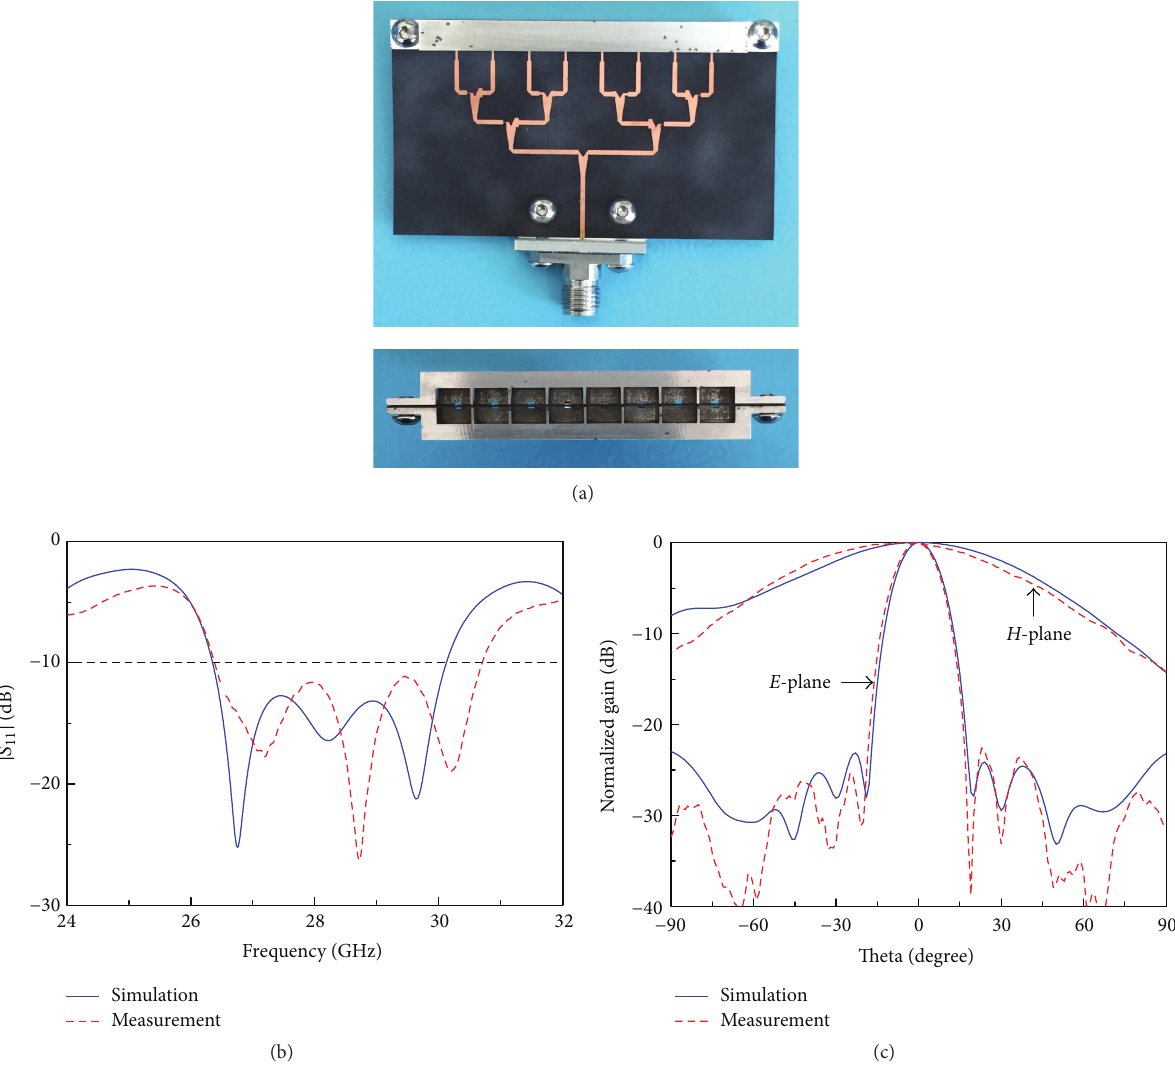
Figure 8: (a) Fabricated sample of the eight-element array with 0 ∘ scan angle: its (b) |𝑆 11 | values and (c) normalized 28GHz pattern.